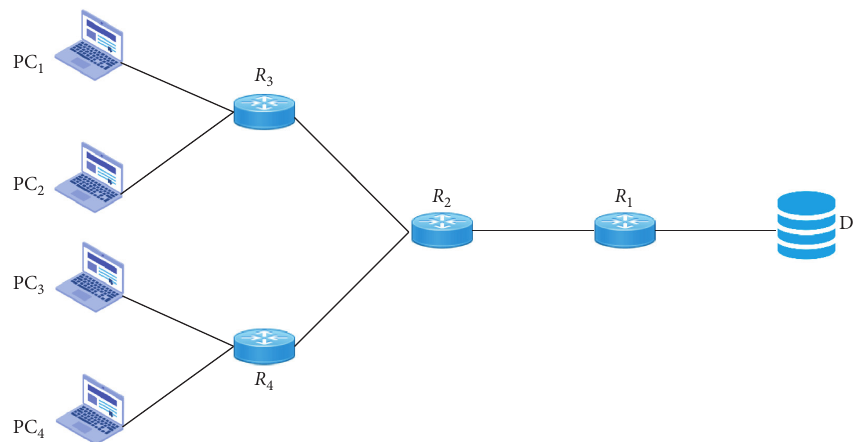
Figure 4: Small-scale tree